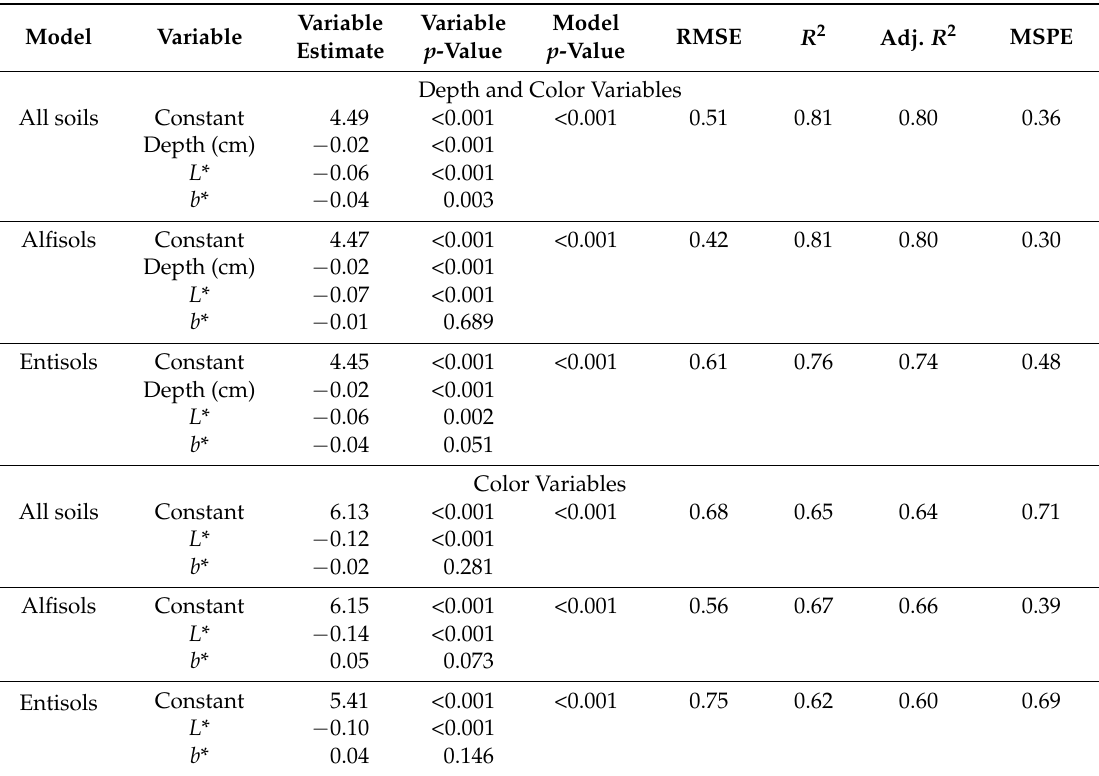
Table 3. Variable estimates and ANOVA results for final prediction models using depth (cm) and color variables, and color variables alone, to predict lnSOC